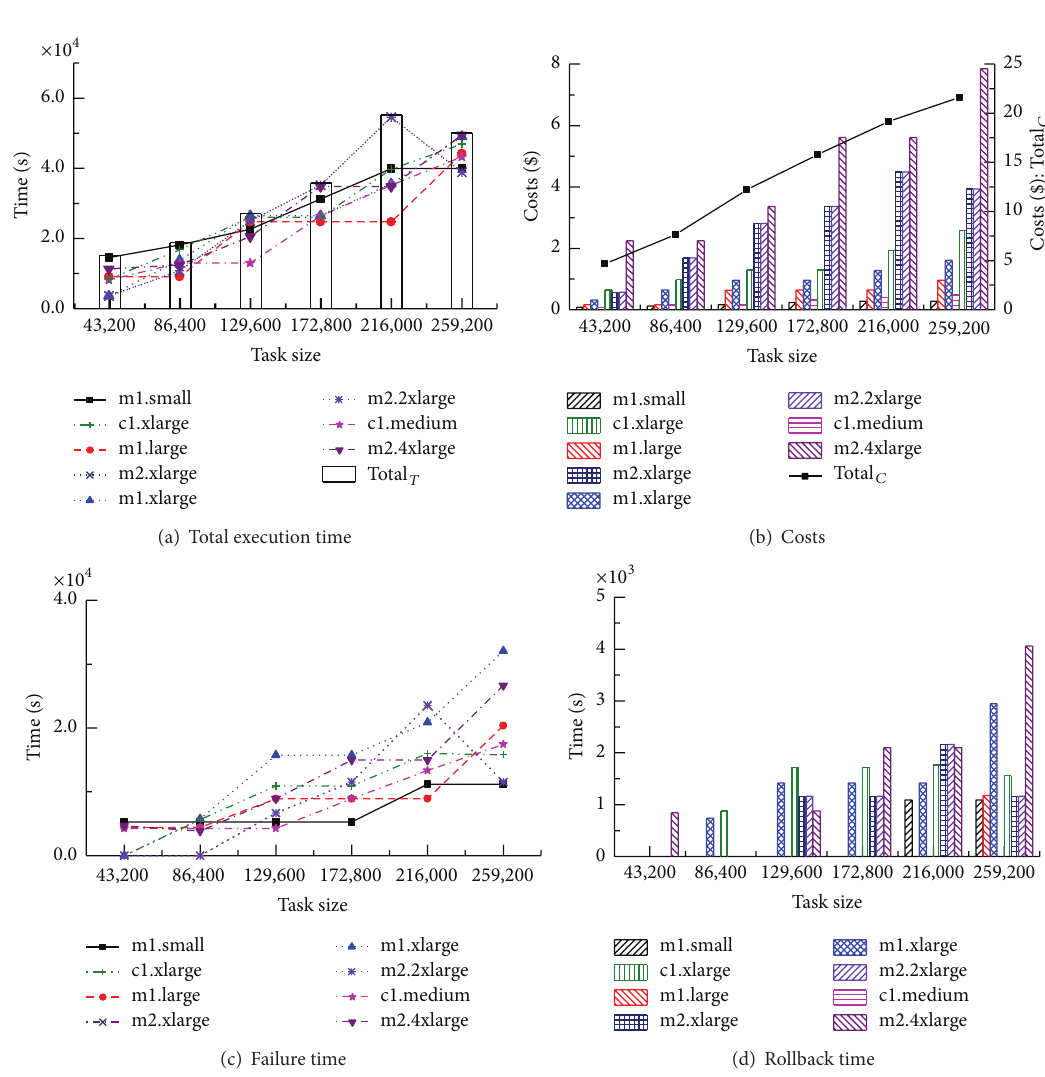
Figure 7: Simulation result in task distribution considering task processing rate.